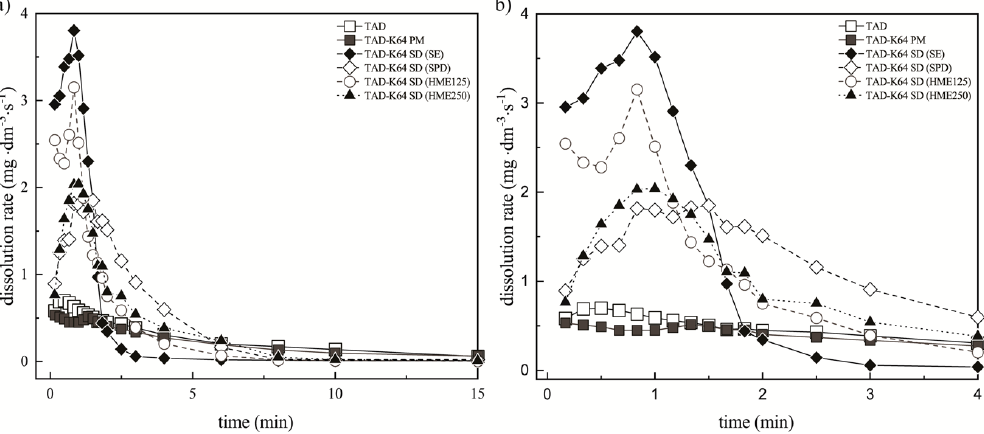
Figure 12. Dissolution rates of TAD from PM and SDs containing K64: ( a ) during 15 min and ( b ) during 4 min.